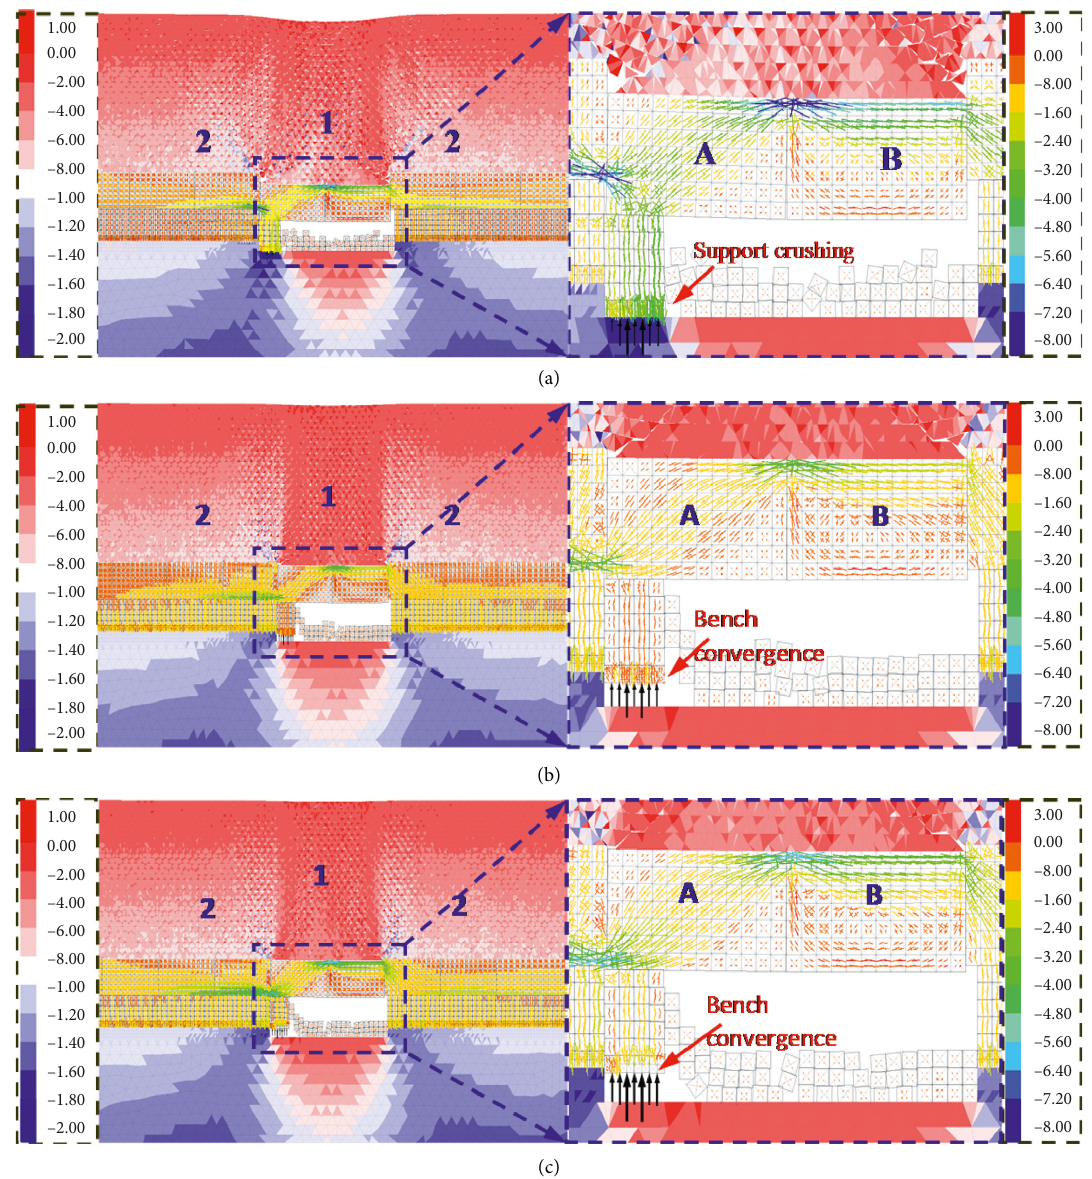
Figure 4: Stope stress distribution during the first weighting: (a) supporting intensity 0.6MPa; (b) supporting intensity 0.8MPa; (c) supporting intensity